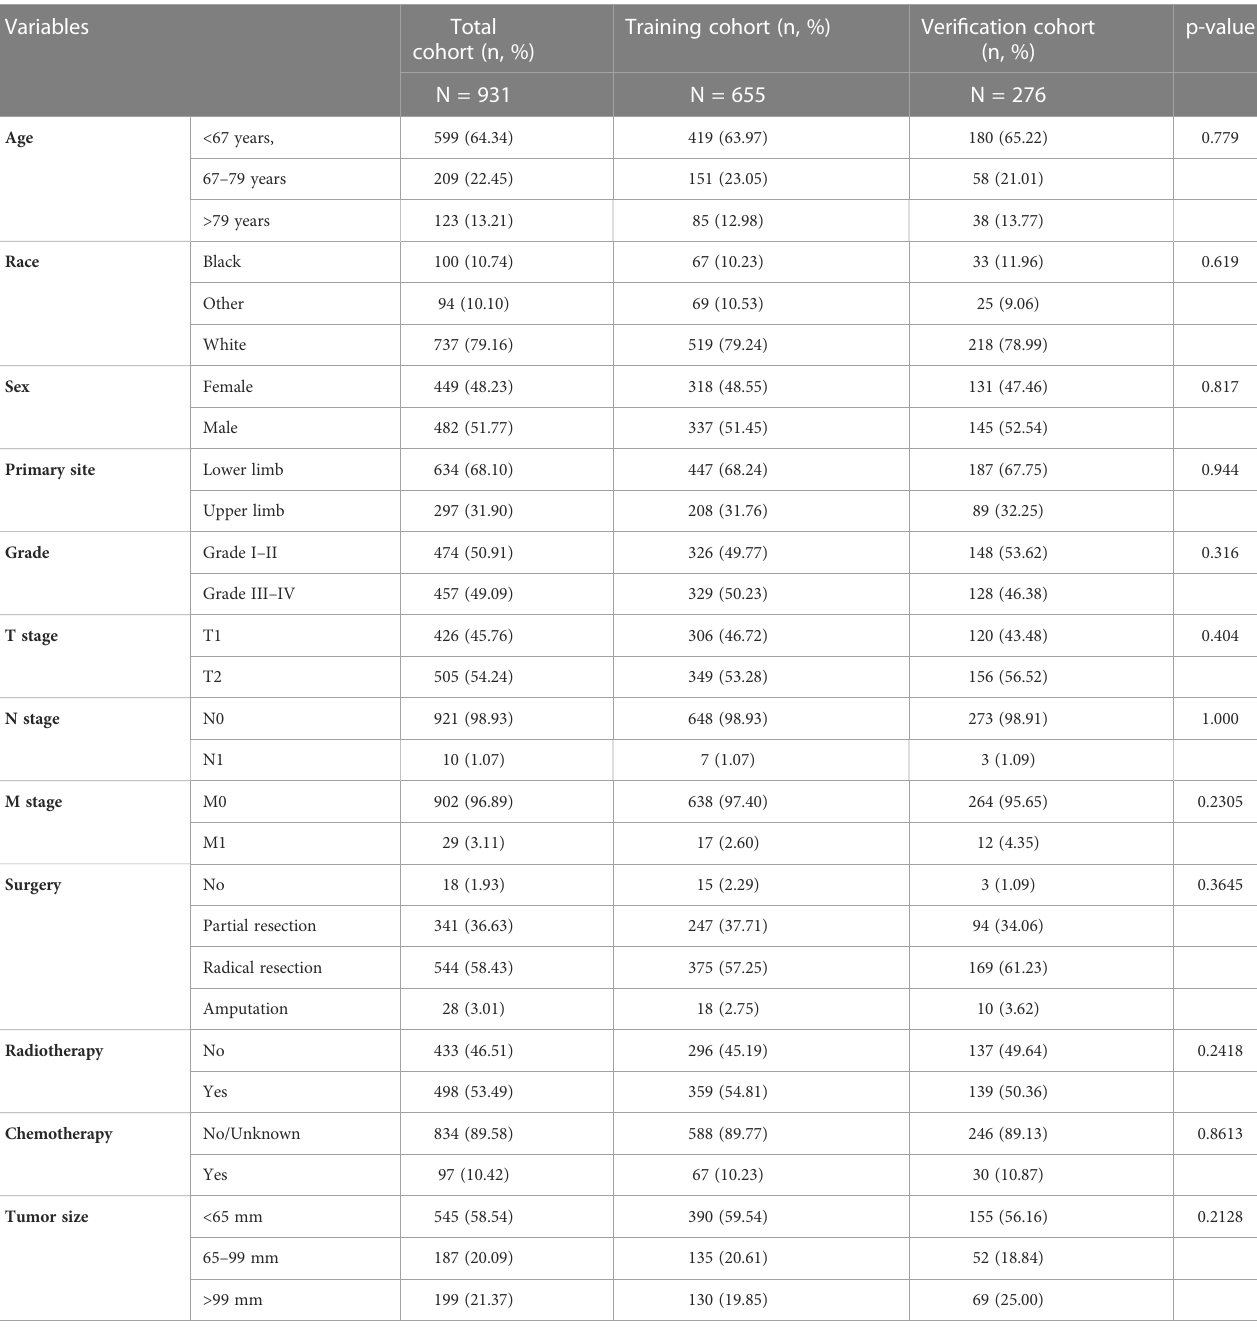
TABLE 1 The demographic and clinicopathologic information of patients with extremity fi brosarcoma (EF).